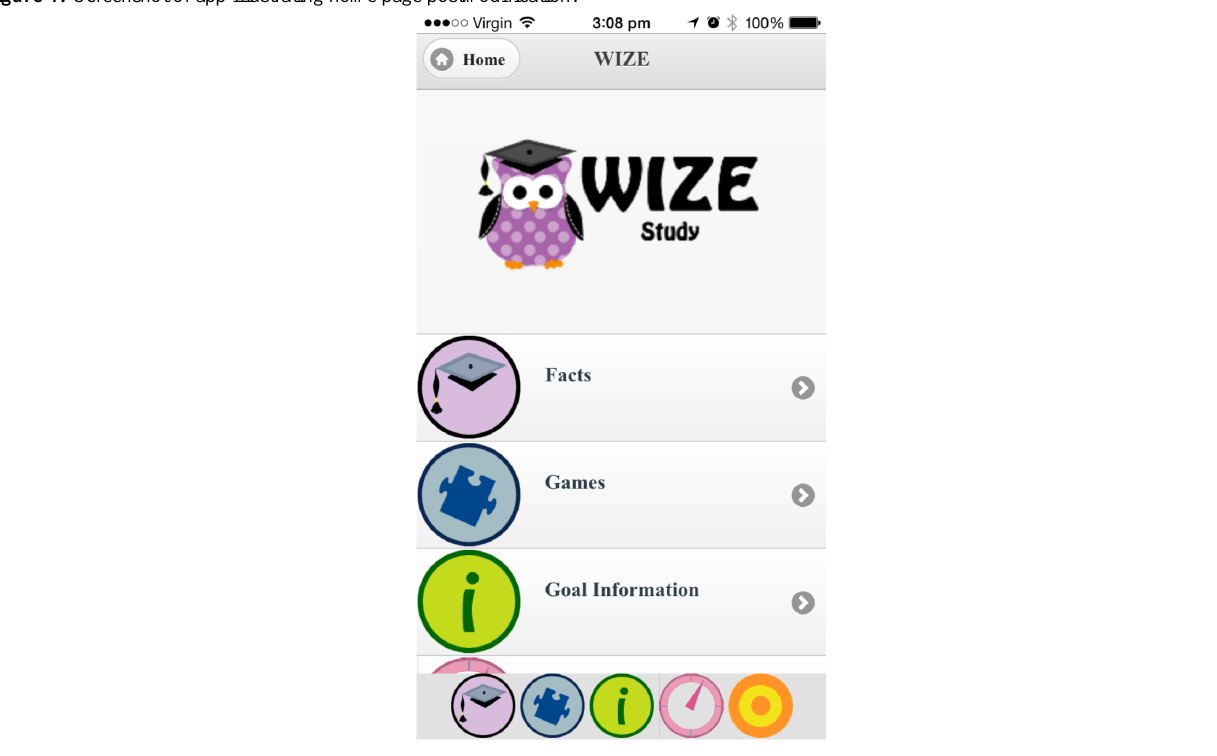
Figure 4. Screenshot of app illustrating home page postmodification.